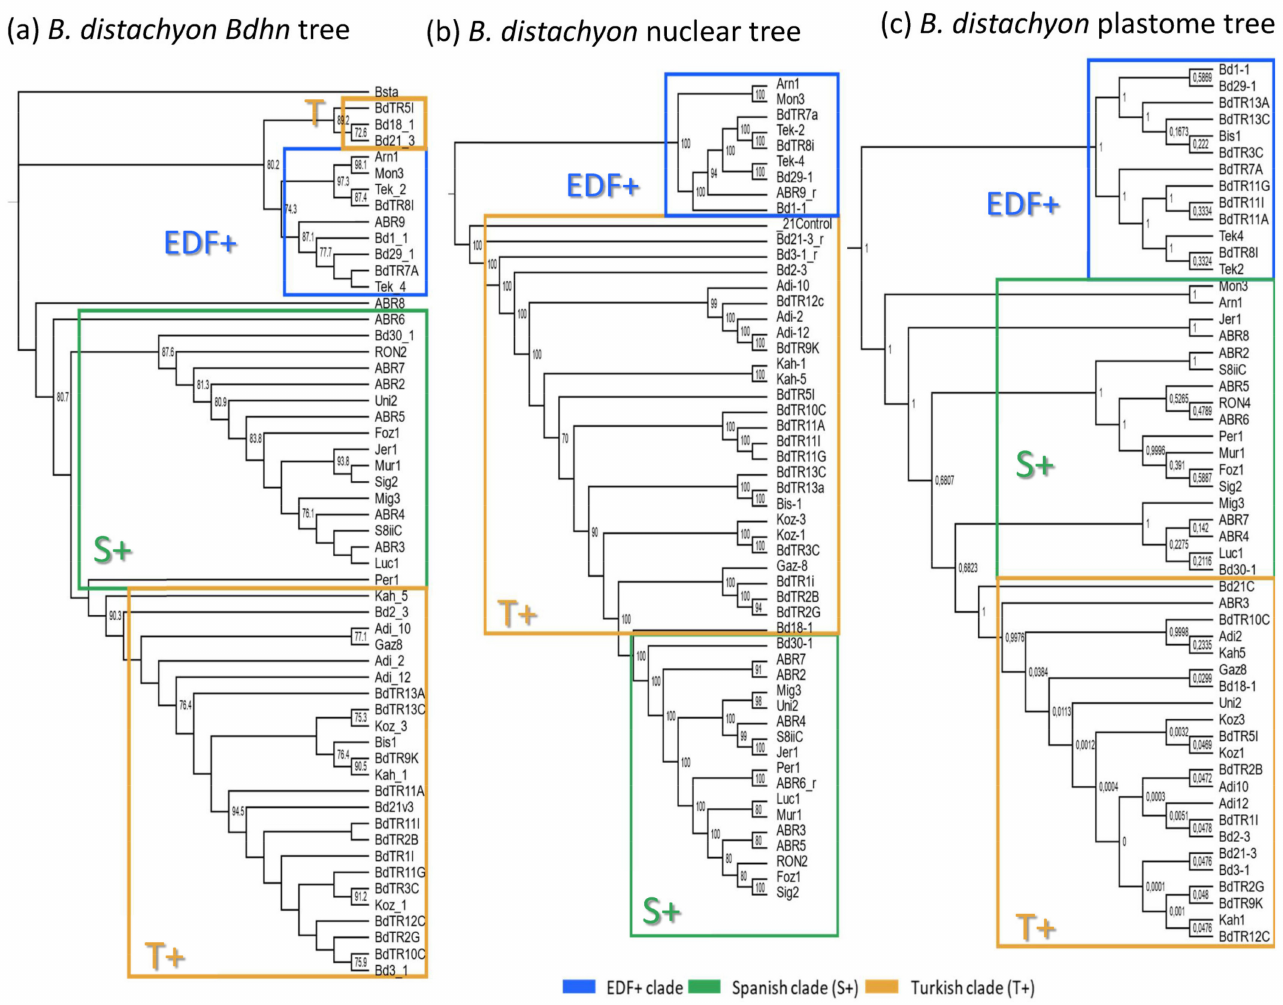
Figure 4. ( a ) Maximum likelihood B. distachyon Bdhn tree. Consensus tree constructed for 54 B. distachyon ecotypes from concatenated exon and intron aligned sequences of six dehydrin genes ( Bdhn 1, Bdhn 2, Bdhn 3, Bdhn 6, Bdhn 7, and Bdhn 8). The EDF+ (extremely delayed flowering time, blue) clade, T+ (Turkish and East Mediterranean, orange), and S+ (Spain and West Mediterranean, green) lineages correspond to those indicated in [37,38]. Bootstrap support is indicated on branches. Accession codes correspond to those indicated in Supplementary Table S4. ( b ) B. distachyon nuclear species tree of [37] based on nuclear genome-wide 3.9 million SNPs. ( c ) B. distachyon plastome tree of [38] based on full plastome